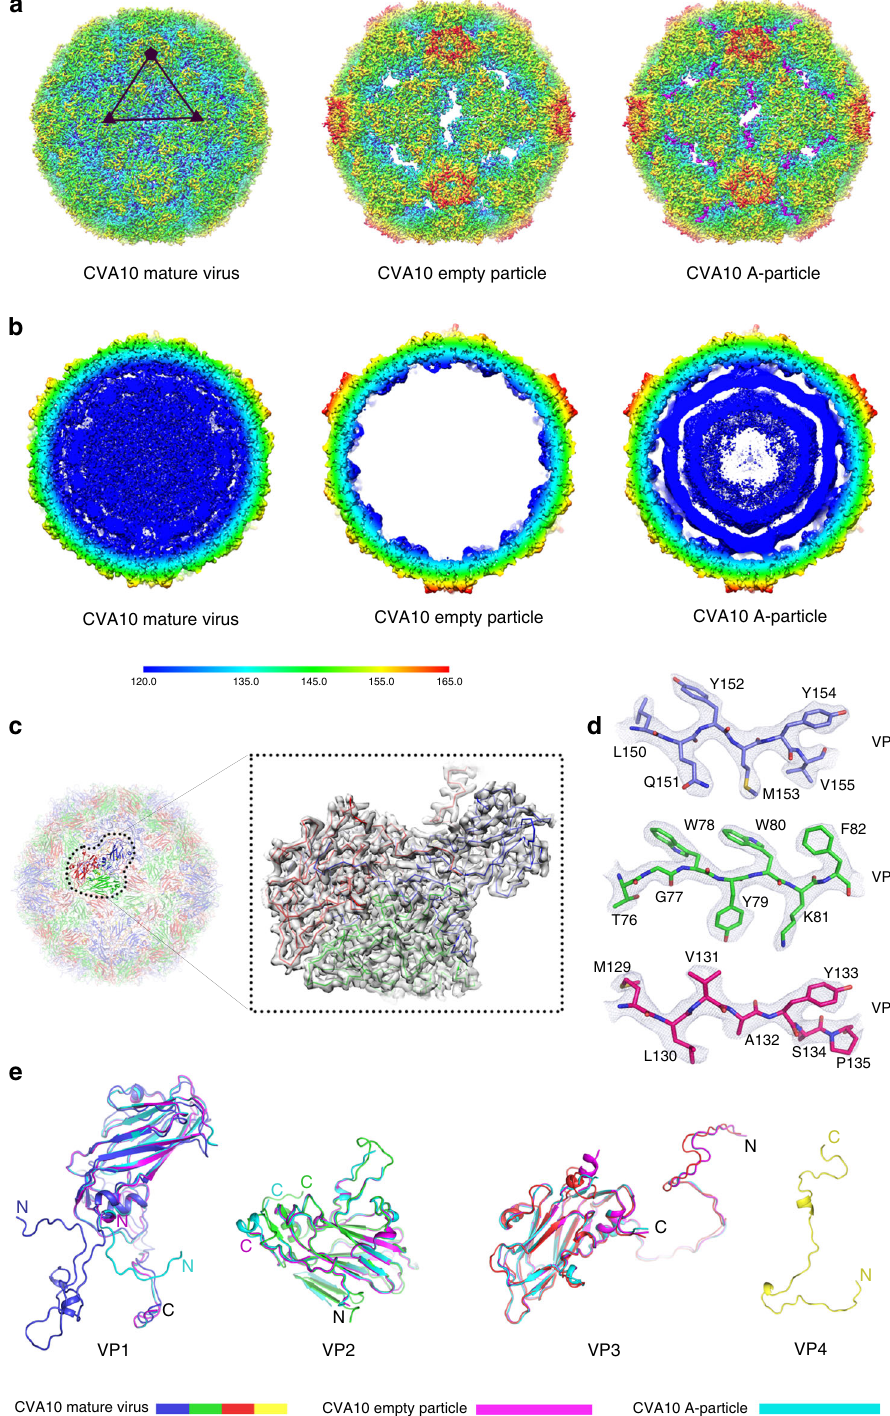
Fig. 1 Cryo-EM structures of CVA10 mature virus, empty- and A-particles. a Three-dimensional reconstructions of CVA10 mature virus, empty- and A- particles viewed along the icosahedral twofold axes. The surfaces are colored radially from blue through green to red from the lowest to the highest radius. One icosahedral asymmetric unit is marked with a black triangle in CVA10 mature virus; icosahedral symmetry axes are drawn in black. The obstructed off- axis channels near the twofold axes in CVA10 A-particle are highlighted in magenta. b Thin slices of the central sections of the CVA10 mature virus, empty- and A-particles viewed down the threefold axes, colored radially from blue through green to red from the lowest to the highest radius. The scale bar applies to both a and b . c Cartoon of the mature CVA10 virus looking down an icosahedral twofold axis (left). The color scheme uses the signature colors (VP1, blue; VP2, green; VP3, red). A single icosahedral protomer is drawn more brightly and the electron density map (gray) for this protomeric unit is accentuated in inset (right). d Electron density maps from a section of VP1, VP2, and VP3, respectively. e Superimpositions of VP1, VP2, and VP3 from CVA10 mature virus, empty- and A-particles, respectively. VP1, VP2, VP3, and VP4 of CVA10 mature virus are colored using classic color scheme, VPs from CVA10 empty particle are shown in magenta, VPs of CVA10 A-particle are displayed in cyan, as shown by the color bars. N-and C-terminus of each protein are labeled in correspondingly colored letters; termini that are overlaid or near are labeled in black